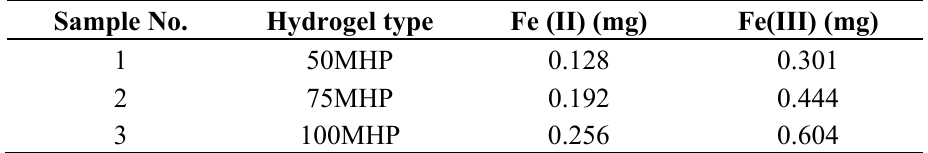
Table 1. Amount of iron salts used to prepare magnetic hydrogels with different iron loadings. Sample